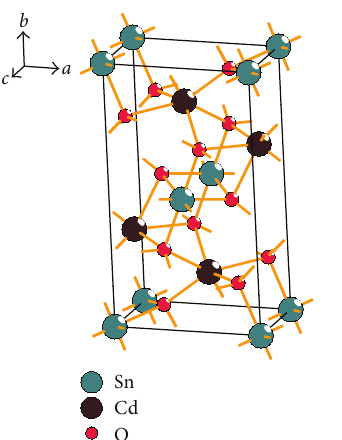
Figure 5: Schematic representation of the crystal structure of orthorhombic Cd 2 SnO 4 .